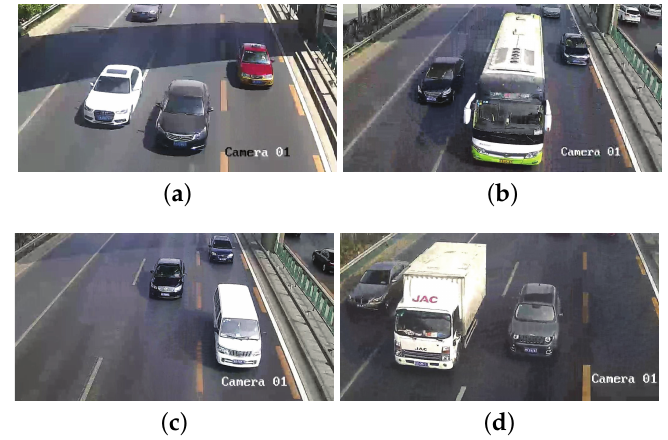
Figure 6. Four sets of real radar scenes in the experiment: ( a ) Scene1; ( b ) Scene2; ( c ) Scene3; ( d )